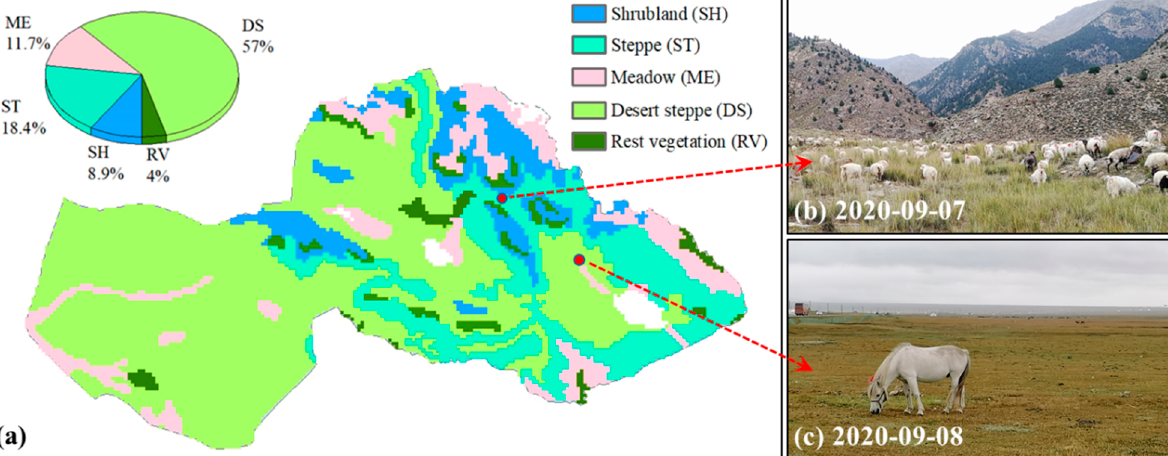
Figure 2. ( a ) Vegetation map of Wulan County, and area proportions of different vegetation types. ( b , c ) Photos of the pasture in Wulan County.